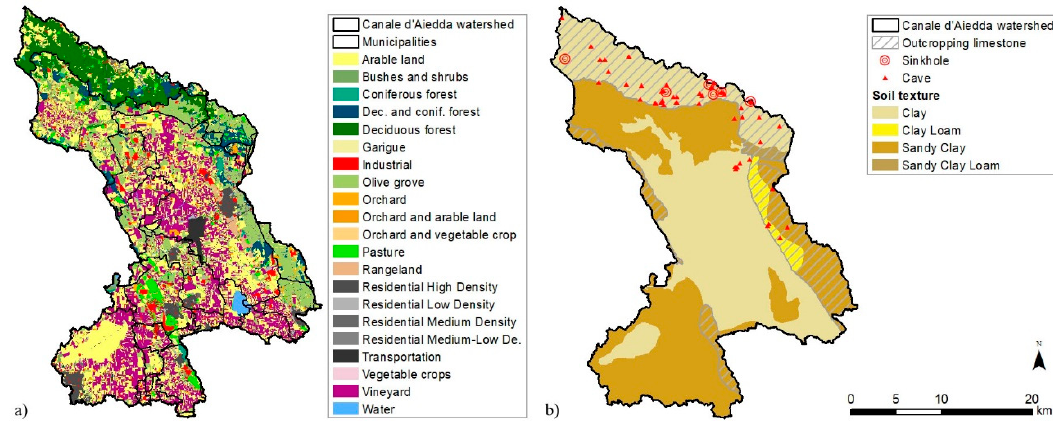
Figure 7. Reclassified land use map ( a ); map of soil texture and main karst units ( b ).